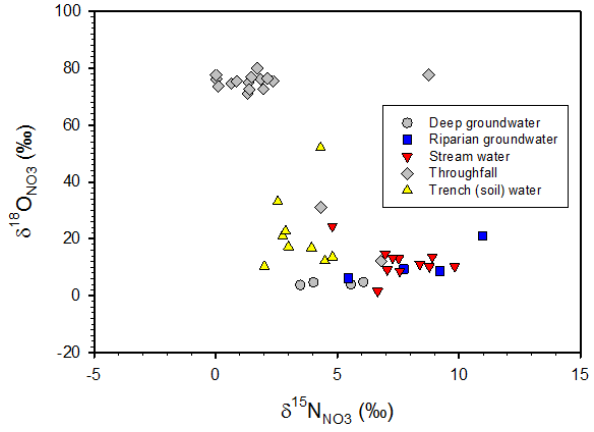
Figure 7. Biplot of δ 15 N NO and δ 18 O NO of nitrate (‰) in water 3 3 samples collected from the intermittent stream (white square), ri- parian groundwater (black circle), throughfall (light grey triangle), deep groundwater (dark grey triangle), and trench flow water (grey diamond) in the R